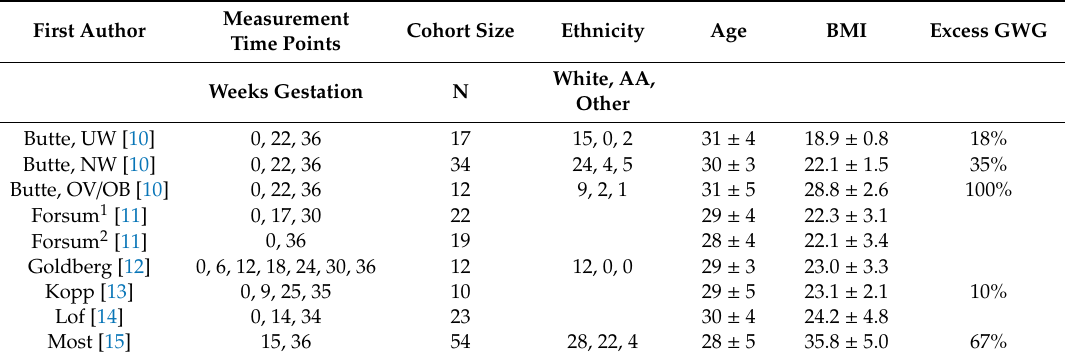
Table 1. Subject Characteristics of Cohorts in Energy Requirement Studies of